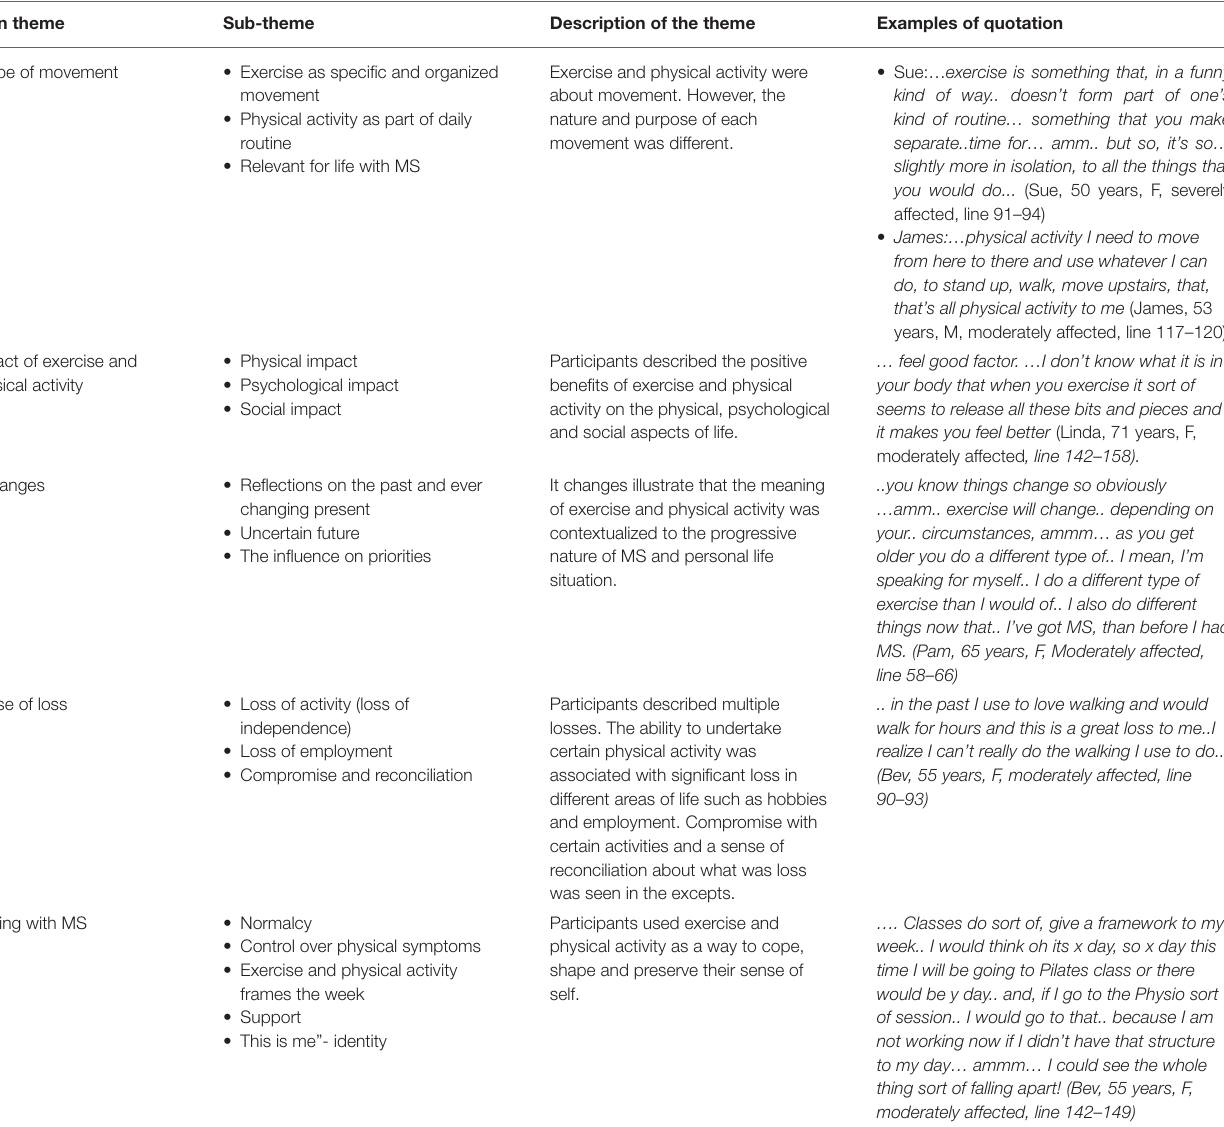
TABLE 2 | Major themes and subthemes for the meaning of exercise and physical